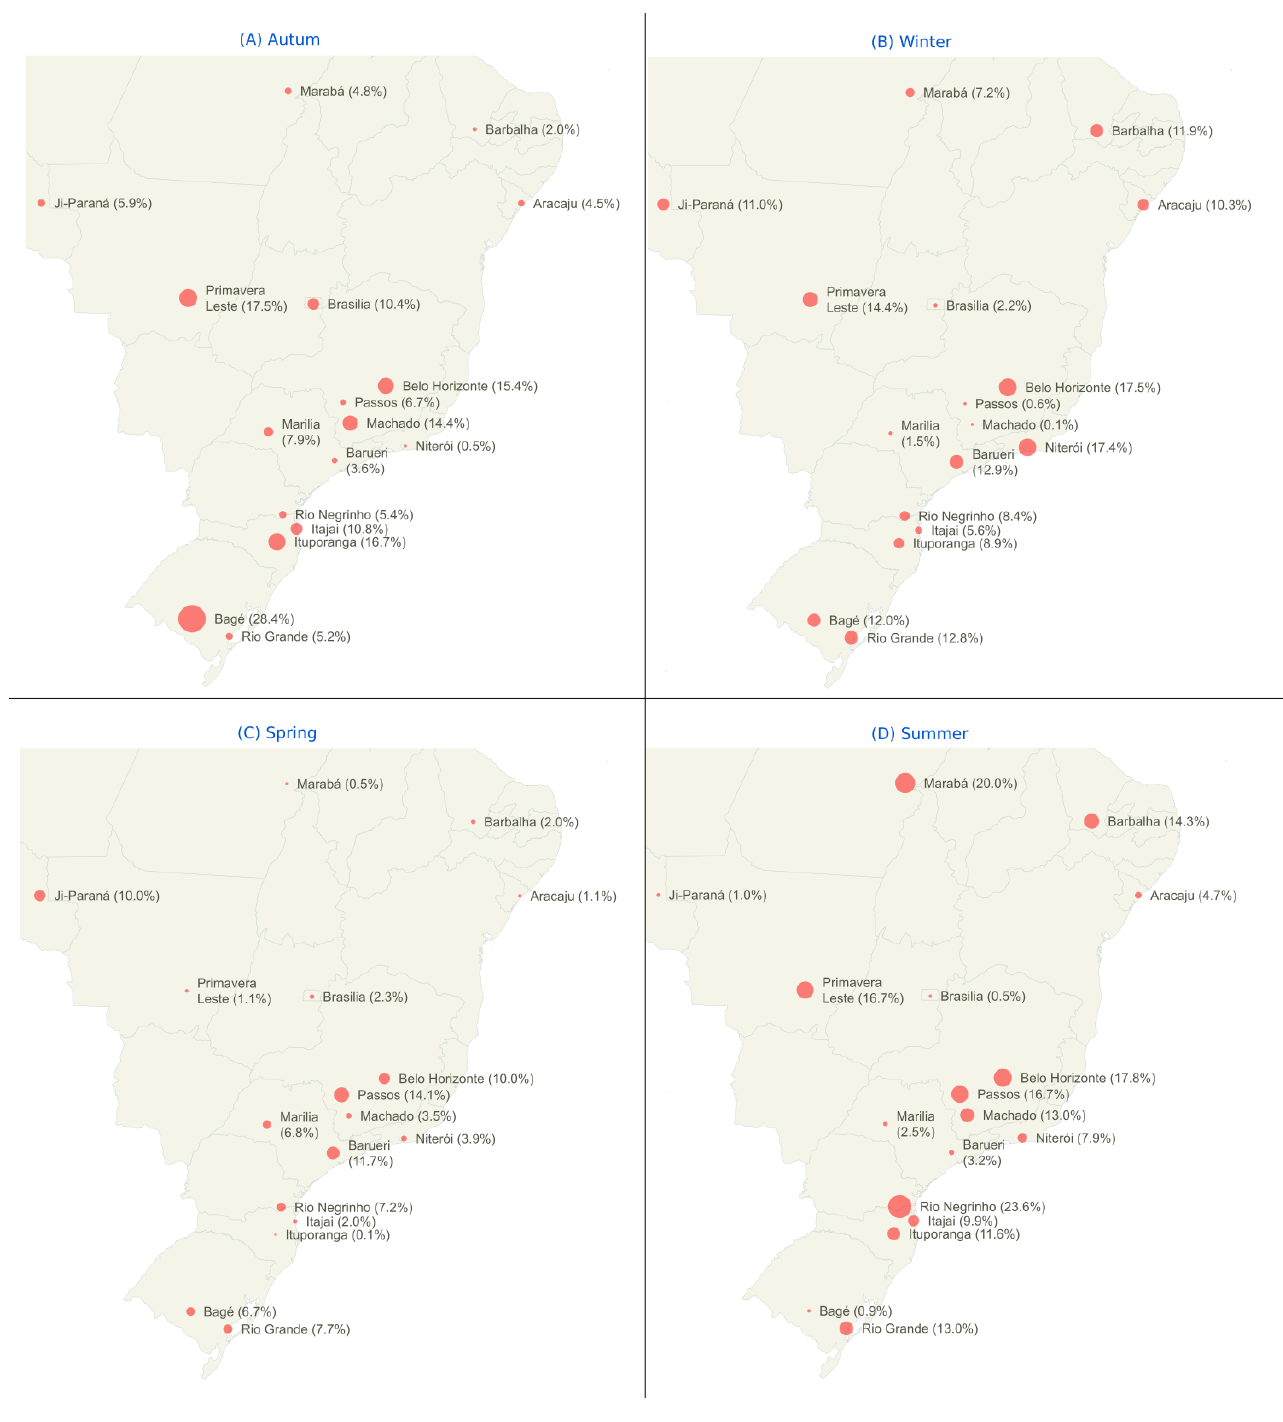
Figure 16. Error intensity map by season: the results displayed are the minimum MAPEs found for each generation plant, after the process of combining the results. The maps were generated using the JavaScript language, through the open source library jQuery MAPAEL [79]. Source: own au-